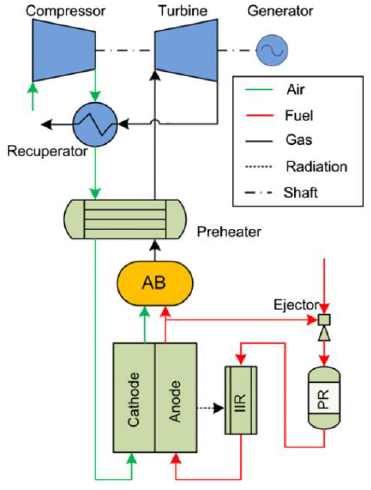
Figure 21. Hybrid SOFC/MGT system [132].